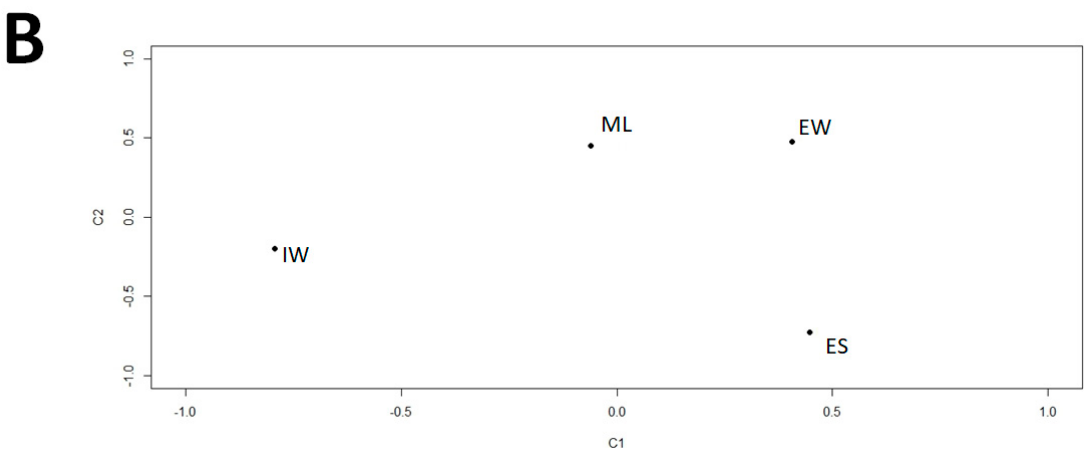
Figure 4. Cluster analysis of the total virome in the WWTP ( A ) and Eukarya-infecting viruses in the WWTP ( B ) calculated by singular value decomposition (SVD).